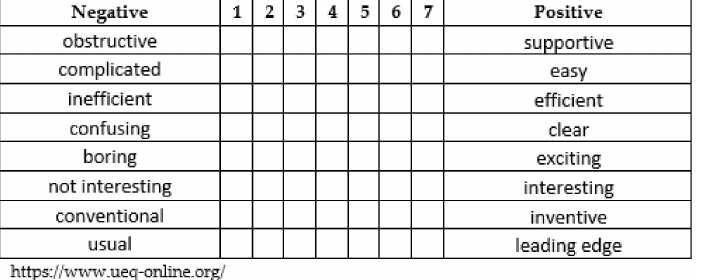
Figure 1. User Experience Questionnaire (UEQ-S). https://www.ueq-online.org/ (accessed